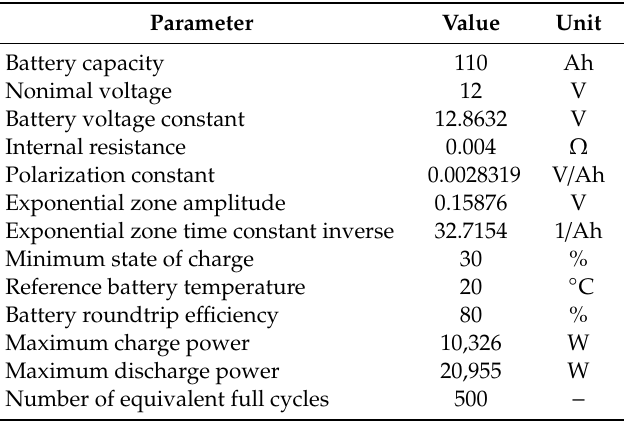
Table 4. Battery bank